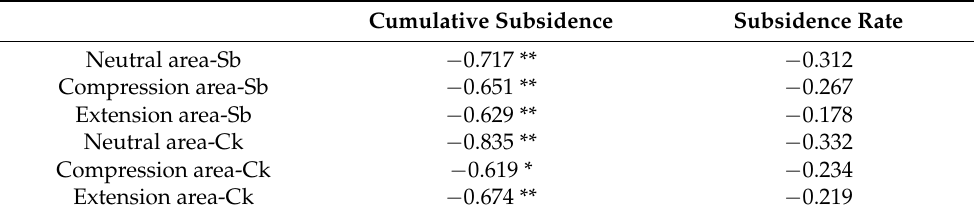
Table 4. The Pearson correlation coefficient between the degradation coefficient and subsidence parameters at the canopy